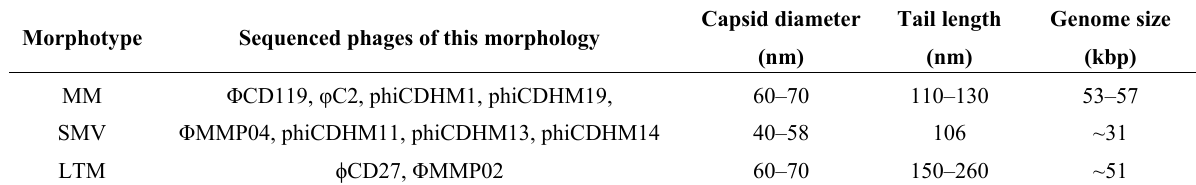
Table 1. Morphological types of sequenced